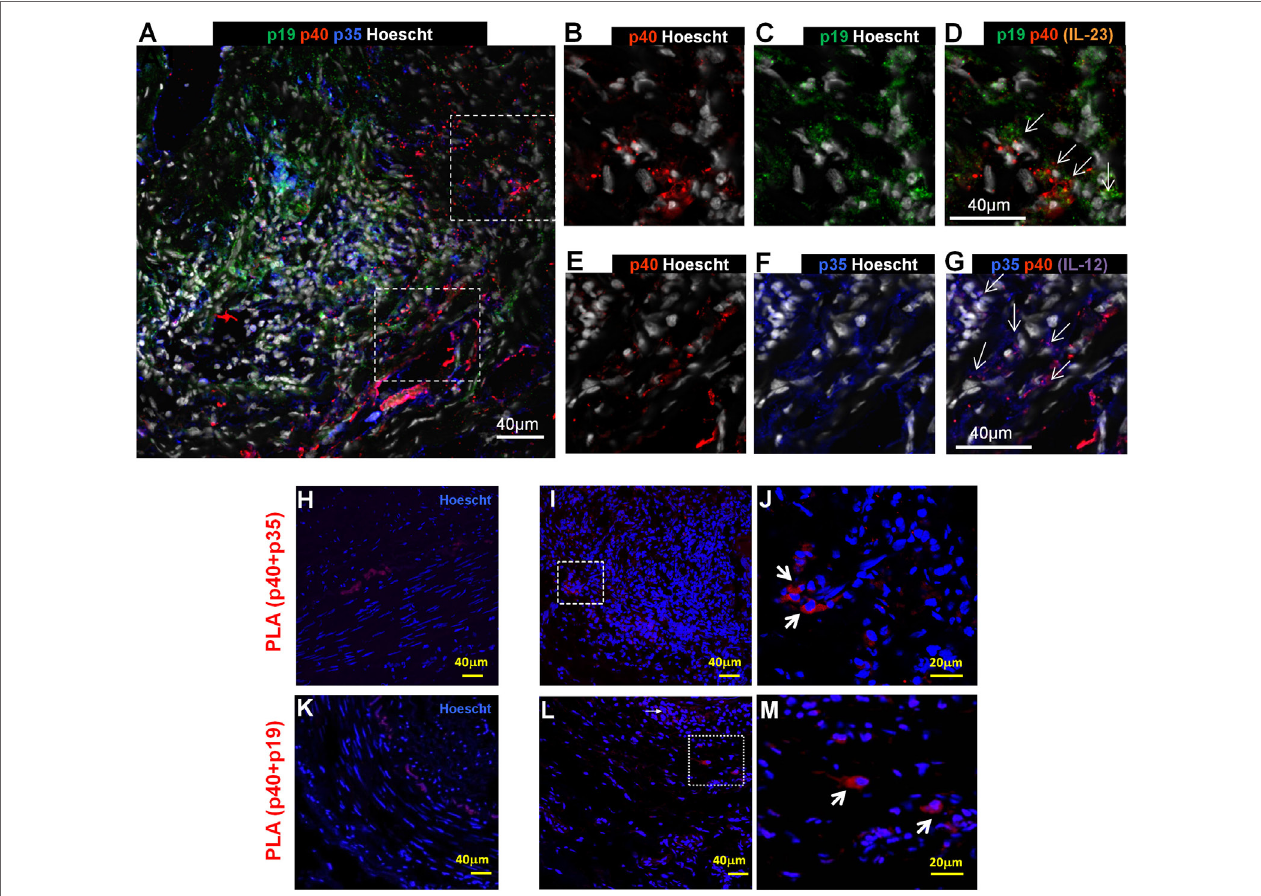
FigUre 3 | Coexpression of subunits to conform IL-12 and IL-23 in temporal artery lesions from patients with GCA. (a) Close-up view of a GCA-involved artery where IL-12p35 + cells (blue) can be observed predominantly in media layer, IL-23p19 + cells (green) in all arterial layers and IL-12/23p40 + cells (red) in the adventitia. (B) Higher magnification of inflammatory cells expressing IL-12/23p40 (red), (c) IL-23p19 (green), and (D) merge showing expression of IL-23 (orange, indicated by arrows). (e) Higher magnification of inflammatory cells expressing IL-12/23p40 (red), (F) IL12p35 (blue), and (g) merge showing expression of IL-12 (purple, indicated by arrows). The temporal arteries were subjected to proximity ligation assay (PLA) to determine proximity of IL-12 and IL-23 subunits. The red staining marks the colocalization ( < 40 nm) of IL-12/23p40 and IL-12p35 (IL-12). Blue (Hoechst) marks the cell nuclei. (h) Negative PLA signalfor colocalization of IL-12/23p40 and IL-12p35 (IL-12) in a control artery. Minimal autofluorescence of the elastic lamina can be appreciated (i) . Positive colocalization of IL-12/23p40 and IL-12p35 (IL-12) in a GCA-affected temporal artery. The boxed area is magnified on the right (J) . (K) Negative PLA signal for colocalization of IL-12/23p40 and IL-23p19 (IL-23) in a control artery. Minimal autofluorescence of the elastic lamina can be appreciated (l) Colocalization of IL-12/23p40 and IL-23p19 (IL-23) in a positive GCA temporal artery. The boxed area is magnified on the right (M)